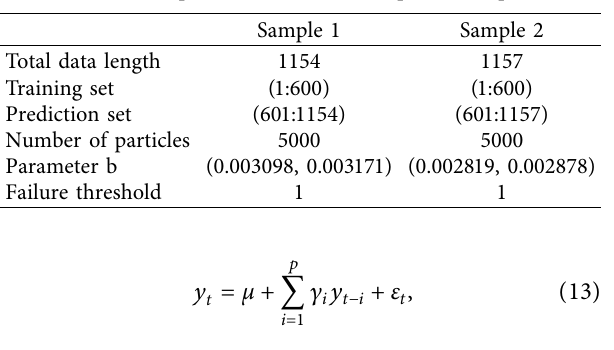
Figure 8: RUL prediction results. Table 3: Initial parameters used in the prediction